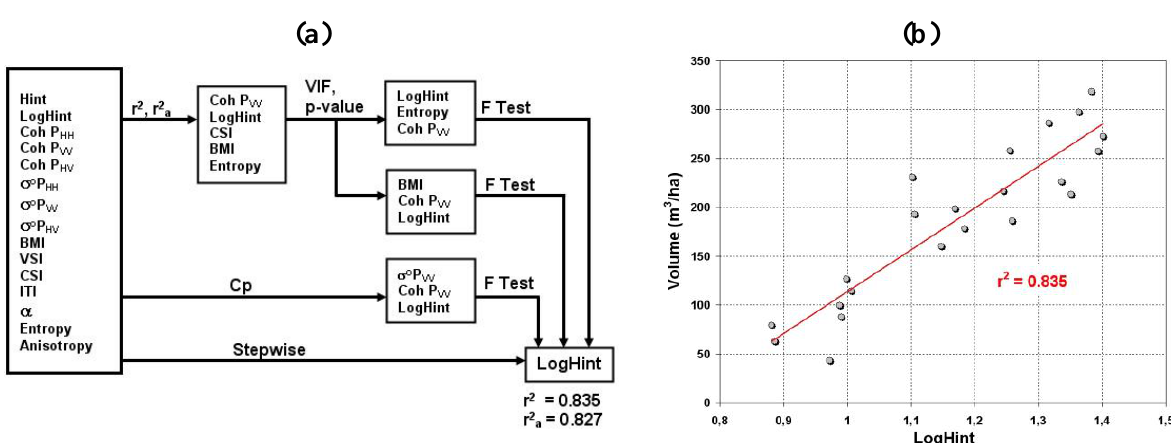
Figure 8. (a) Flow diagram of variables selection; (b) Graph of volume regression model.